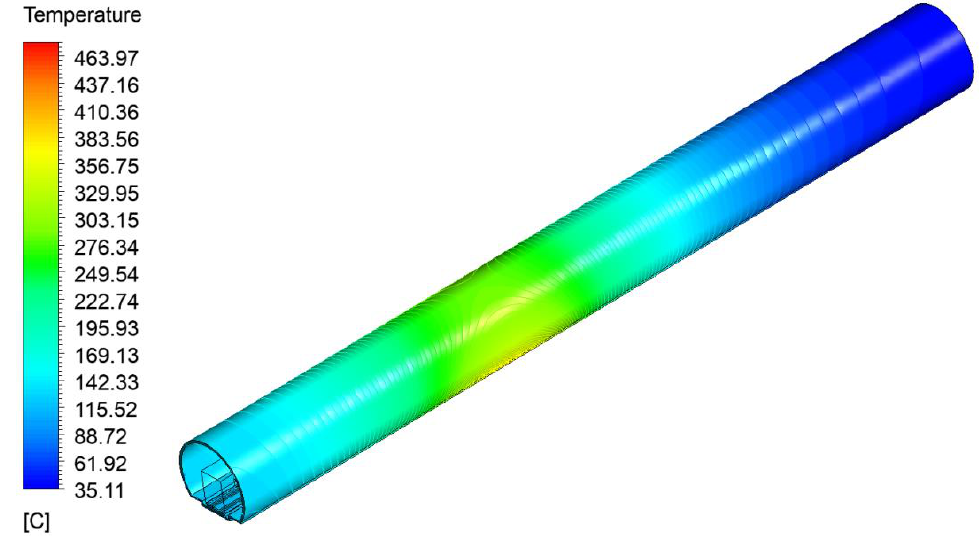
Figure 10. Temperature cloud of the tunnel vault along the longitudinal direction.